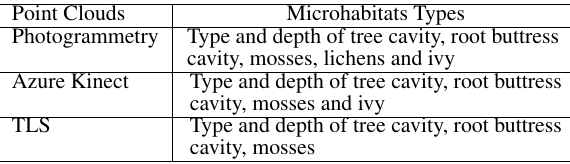
Table 4. Summary of microhabitats in the Rameren